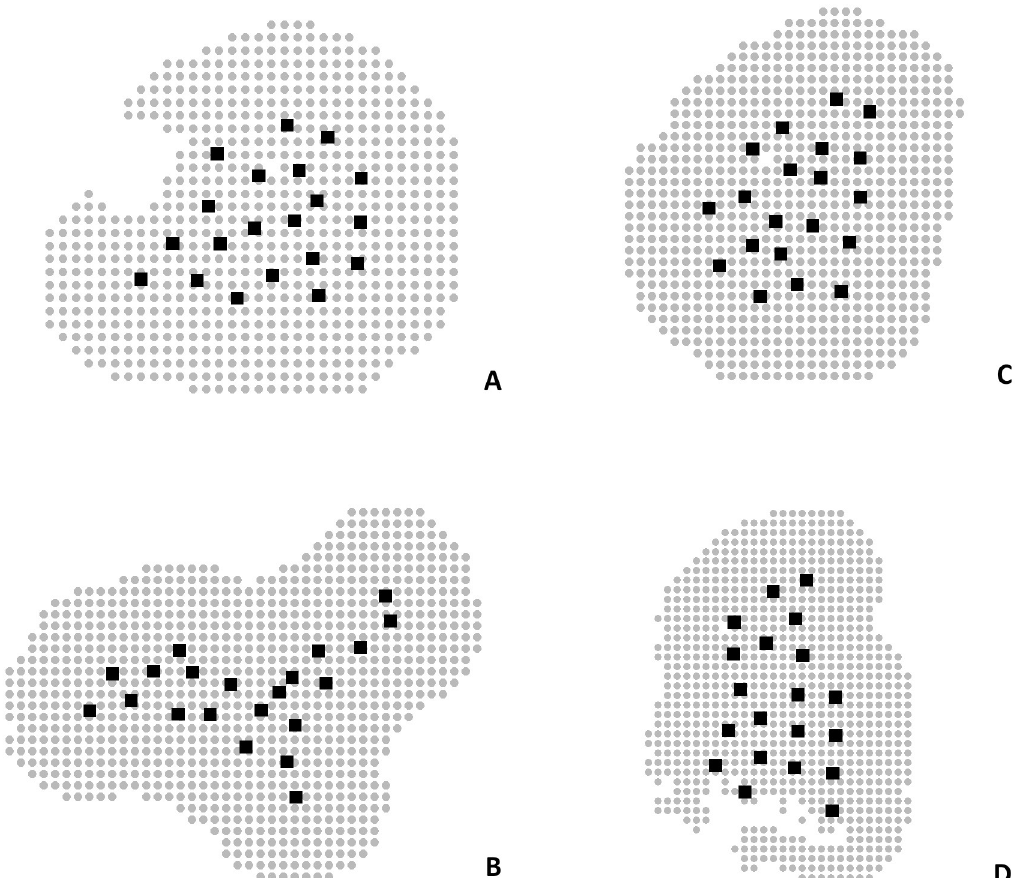
Fig 3. State spaces created for the sampled areas. Black squares represent locations of the camera-trap stations and grey points represent the pixel centroids of the state space of the sampled area. A) Banhado dos Pachecos Wildlife Refuge (BPWR), B) Pro´- Mata Center for Research and Conservation of Nature (PROMATA), C) Teutoˆnia (TEUT), D) Passo Fundo National Forest (PFNF). Note the water coordinates removed in A and D.